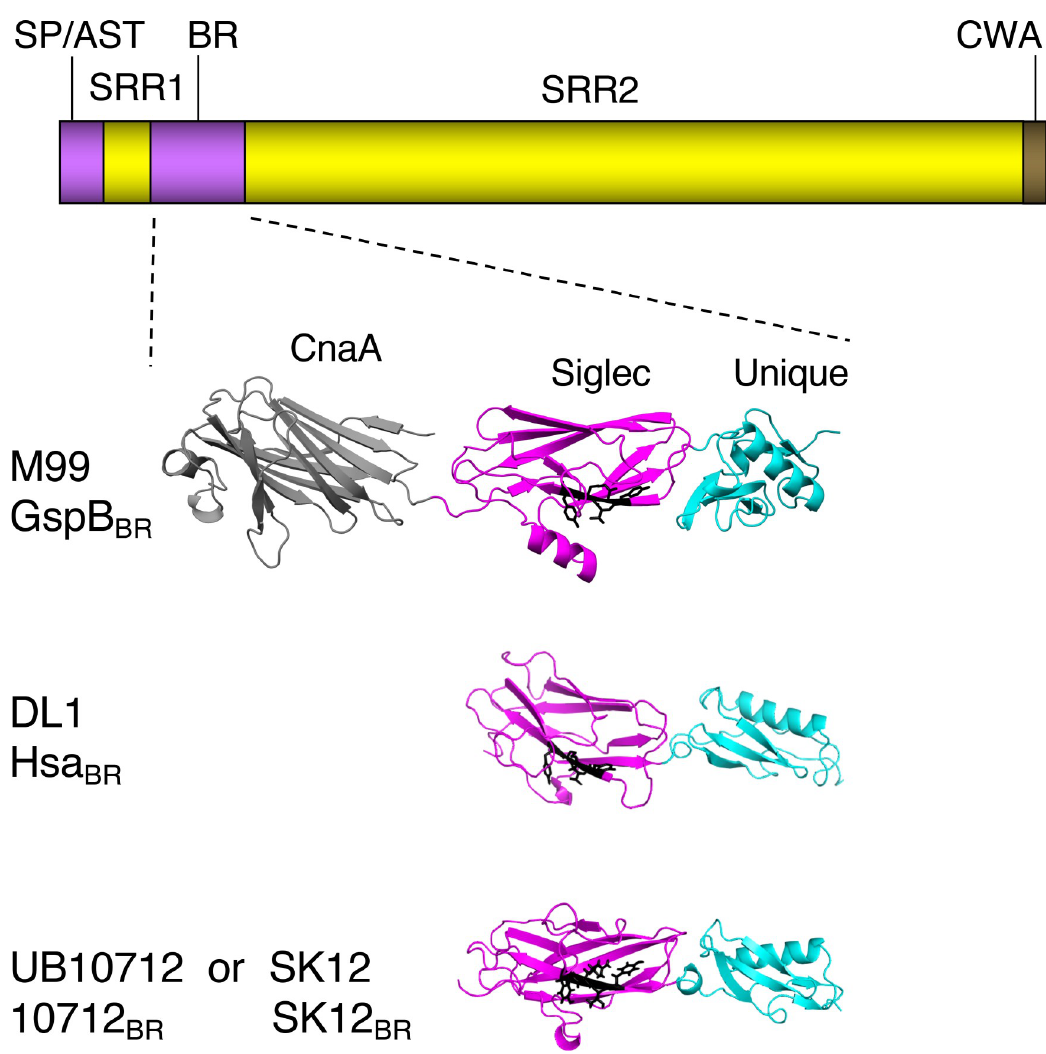
Fig 1. Comparison of the GspB, Hsa and 10712 BRs. The upper diagram shows the general domain organization of the SRR glycoproteins. SP/AST, signal peptide and accessory Sec transport domain; BR, ligand binding region; CWA, cell wall anchor. The SRR1 and SRR2 regions undergo glycosylation in the bacterial cytoplasm, prior to transport by the accessory Sec system. The lower portion shows high-resolution crystal structures of the binding regions of GspB, Hsa and the SRR glycoprotein from the S . gordonii strain UB10712. The GspB BR structure was reported previously [30]. Partially refined structures of the Hsa BR and 10712 BR were provided by T. Iverson (manuscript submitted; PDB files 6EFC and 6EFF pending release). Note that the GenBank entry for the 10712 BR sequence originally listed the source strain as Streptococcus mitis NCTC10712 (GenBank JYGN00000000) [66]. The S . gordonii SK12 BR sequence is identical to that of UB10712, and was obtained by translation of the publicly available partially assembled SK12 genome (NZ_LAWP01000015). The CnaA domain is found in some Siglec-like BRs but does not contribute to sialoglycan binding. The sialoglycan ligand preferences thus far appear to be dictated by the Siglec domains. The YTRY motif residues are shown as black sticks. The Unique domain may modulate the conformation of the Siglec domain.